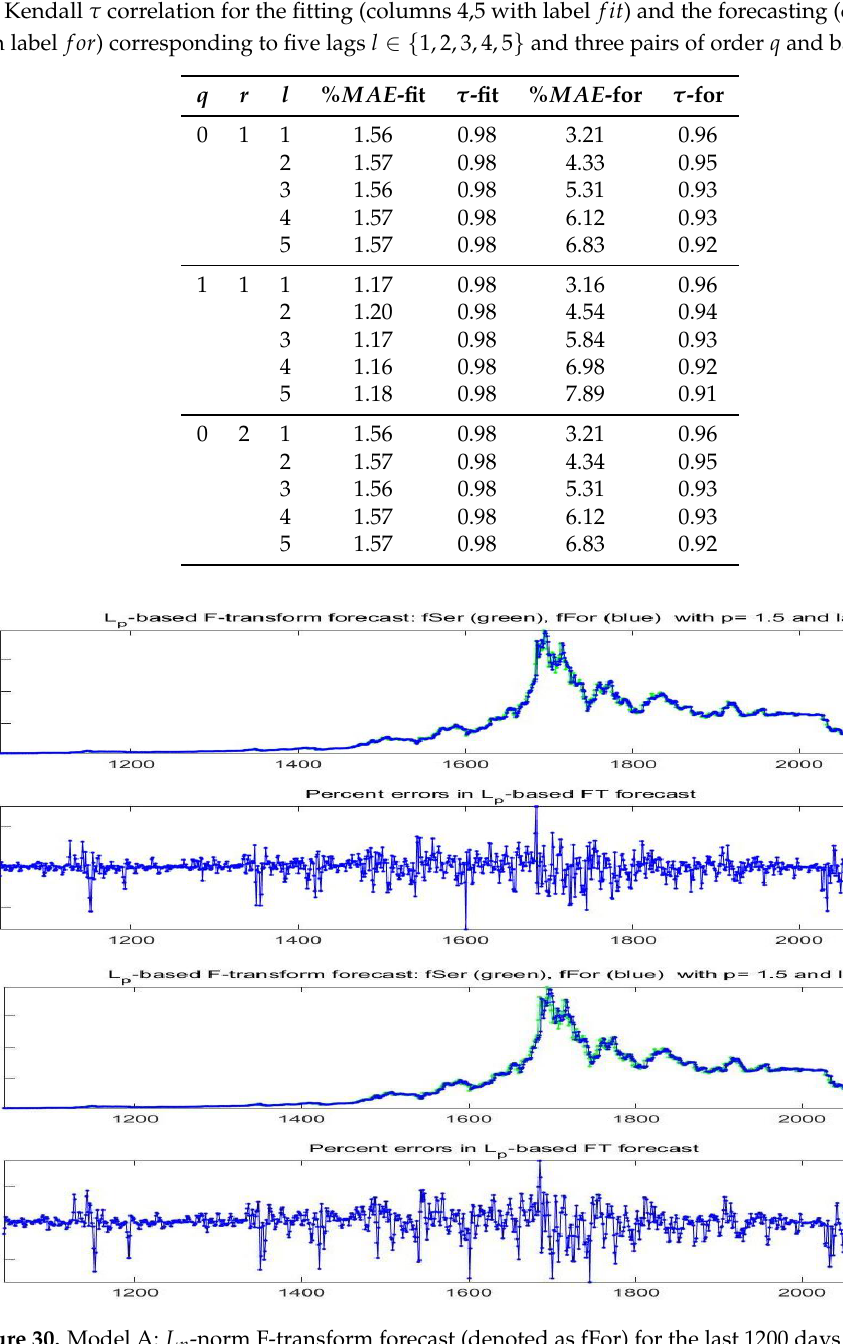
− fFor t are also fSer t